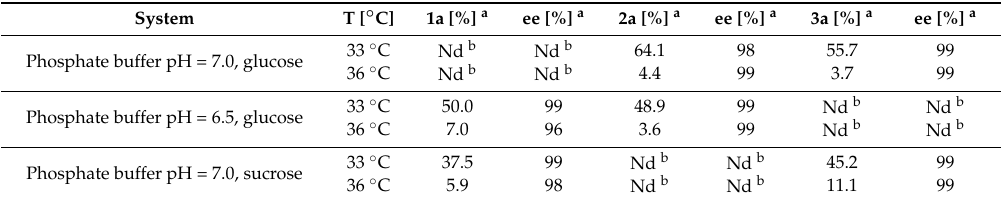
Figure 2. Reduction of 3 in phosphate buffer solution (pH = 7.0) with glucose. Table 3. Reduction of 1 – 3 by Aureobasidium pullulans at 33 ° C and 36 ° C.